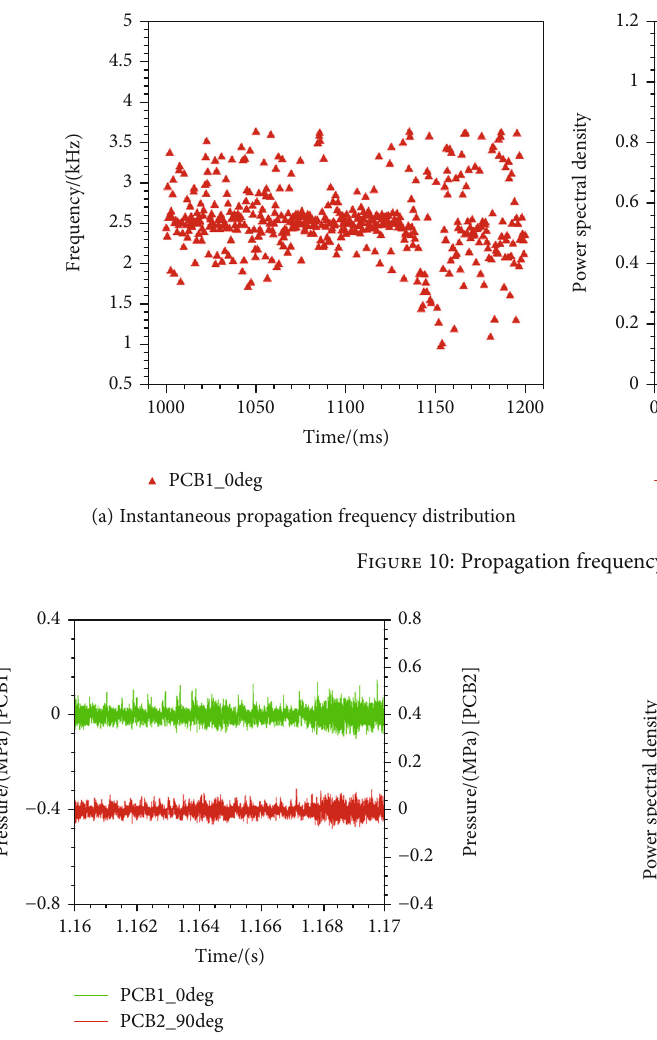
Figure 11: Local view of high-frequency dynamic pressures of Test #3.